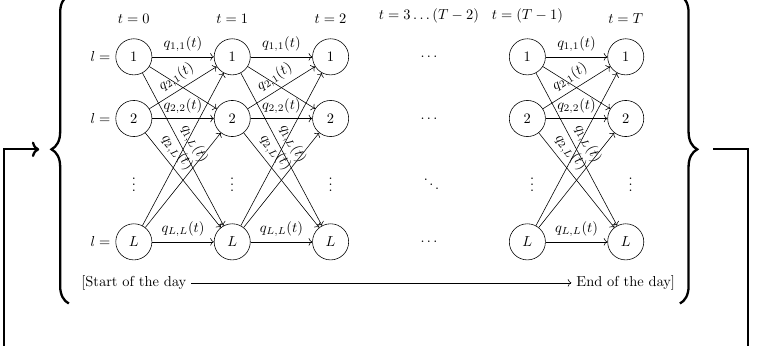
Figure 2. Representation of the time-inhomogeneous Markov chain for a single cluster. The L states are equiprobable, but the transition probabilities q i , j ( t ) change as a function of the time step t = 1 . . . T . A cyclic random walk throughout the chain is generated to produce SLPs with a duration longer than one